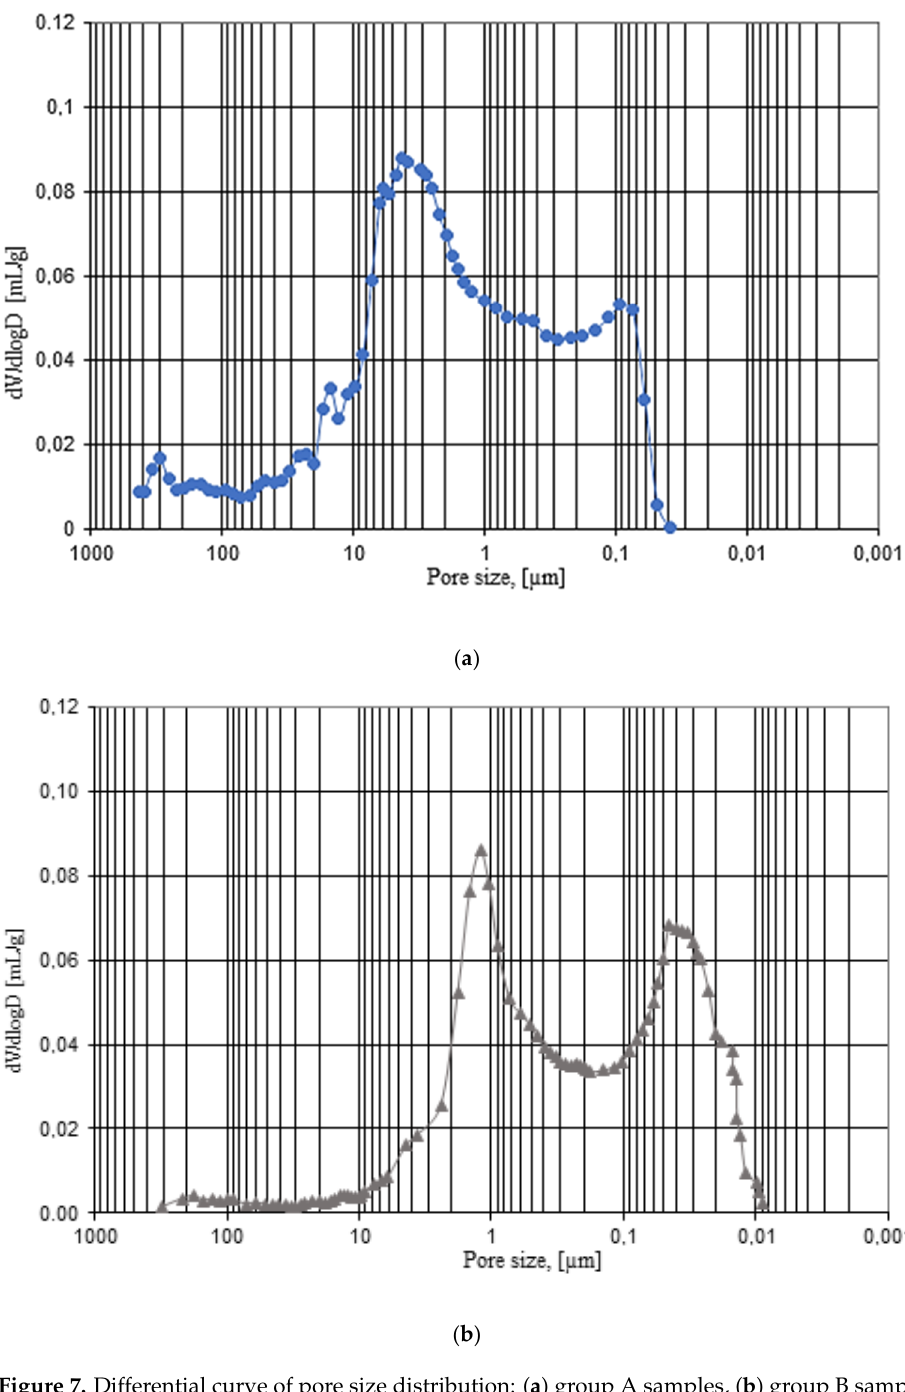
Figure 7. Differential curve of pore size distribution: ( a ) group A samples, ( b ) group B samples.